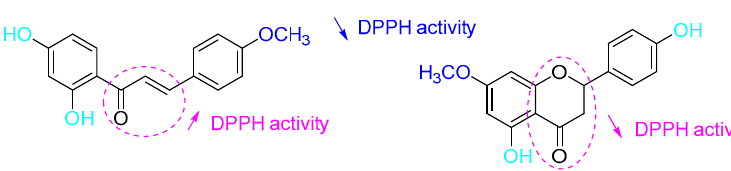
Figure 2. Structure / activity relationships established for DPPH scavenging activity.